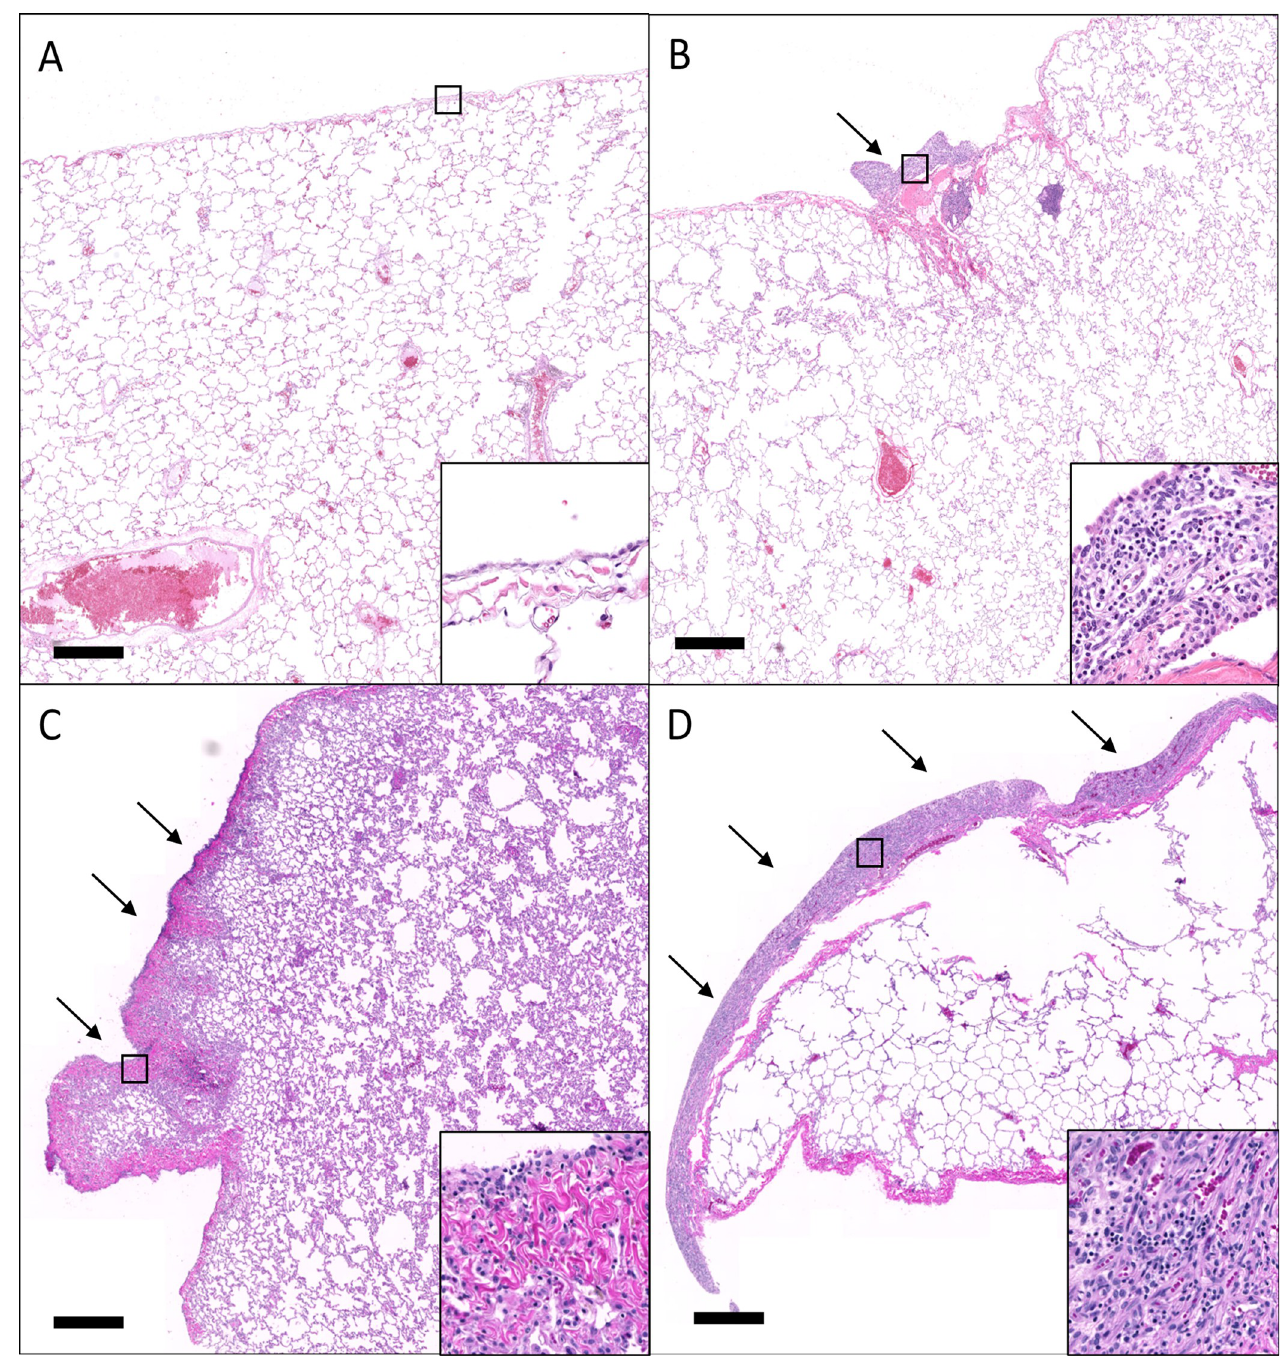
Fig 7. Pleuritis in SARS-CoV-2 infected animals. A) Normal pleura from a na ï ve animal. B-D). SARS-CoV-2 infected animals exhibited variable pleuritis (arrow) ranging from minimal (B) to mild (C) to moderate (D). Insets of the boxed regions show the magnitude of thickening and infiltration by inflammatory cells. H&E. Bar = 1